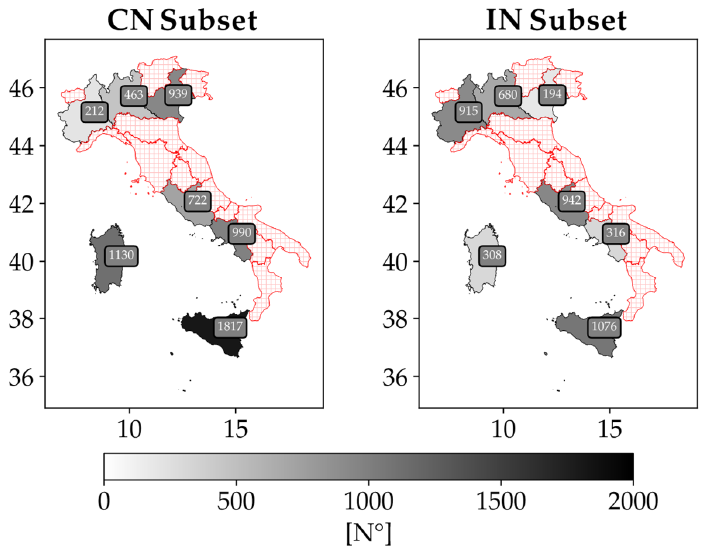
Figure 20. Number of voltage dips recorded at regional level for the CN and IN Subsets.